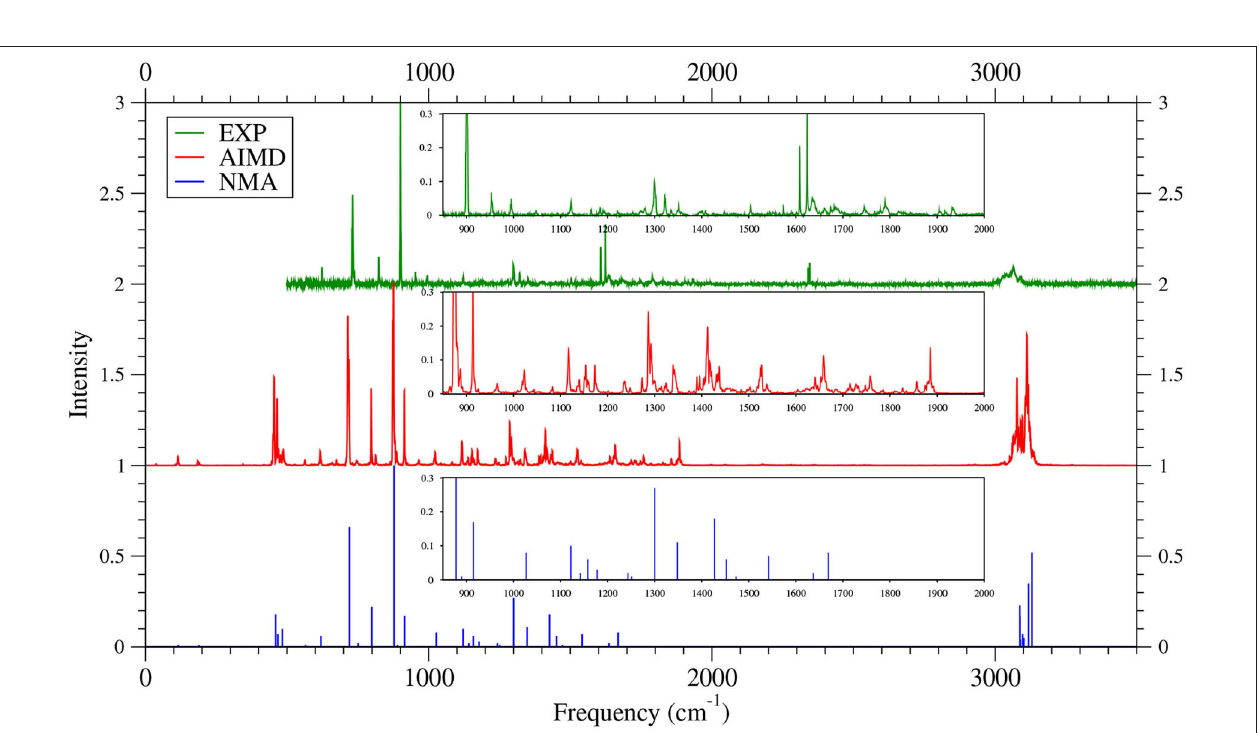
FIGURE 9 | IR spectra of 5-acene, obtained with the TAO-AIMD simulations at 300 K and GS-NMA, calculated by TAO-LDA. Experimental (EXP) data (Hudgins and Sandford, 1998b; Boersma et al., 2014; Bauschlicher et al., 2018; Mattioda et al., unpublished) are included for comparison. The IR spectra are normalized to have a maximum intensity of one and, for clarity, are vertically offset from each other by the same value. Subfigures show the IR spectra in the 850–2,000 cm − 1 range.